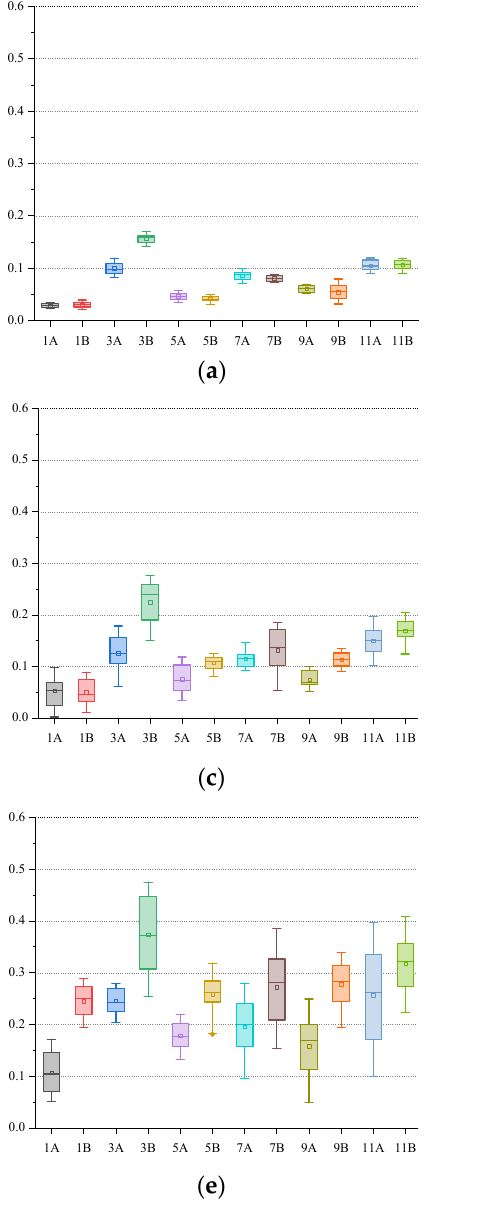
Q , and the top and bottom